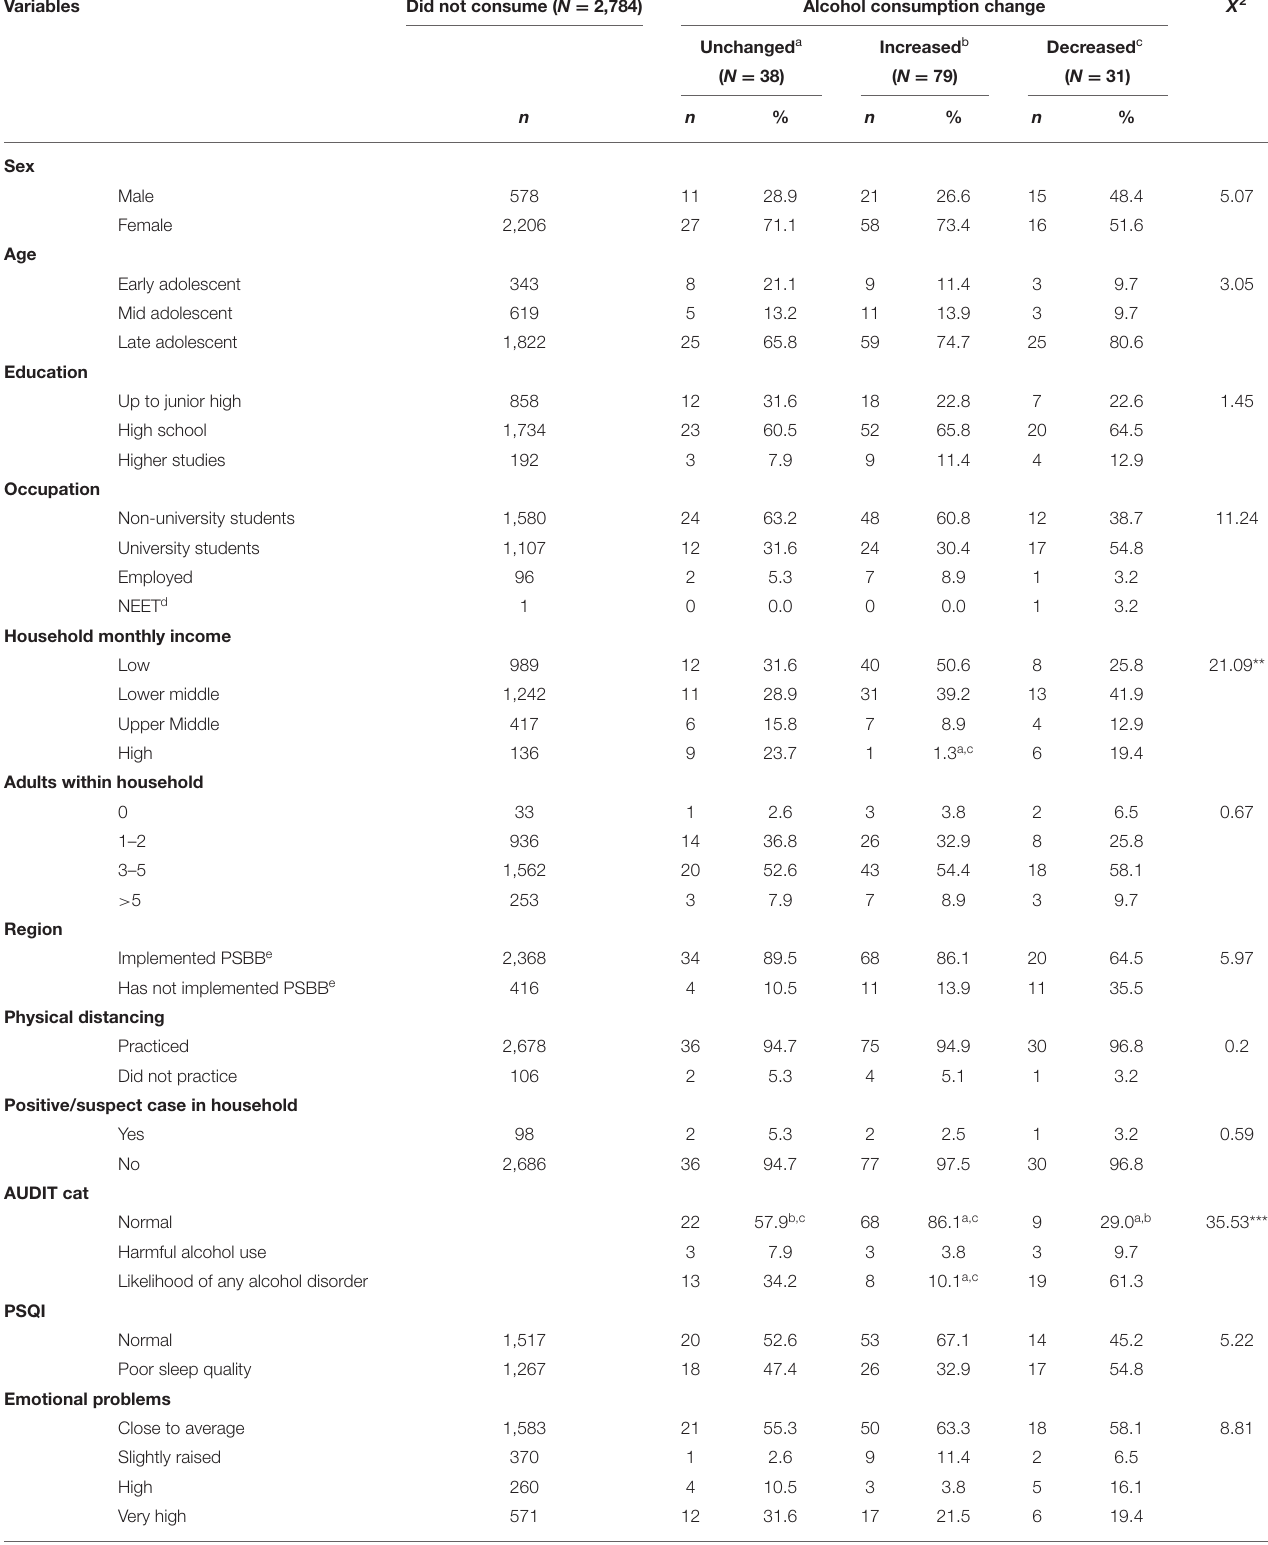
TABLE 1 | Descriptive data stratified by alcohol consumption.